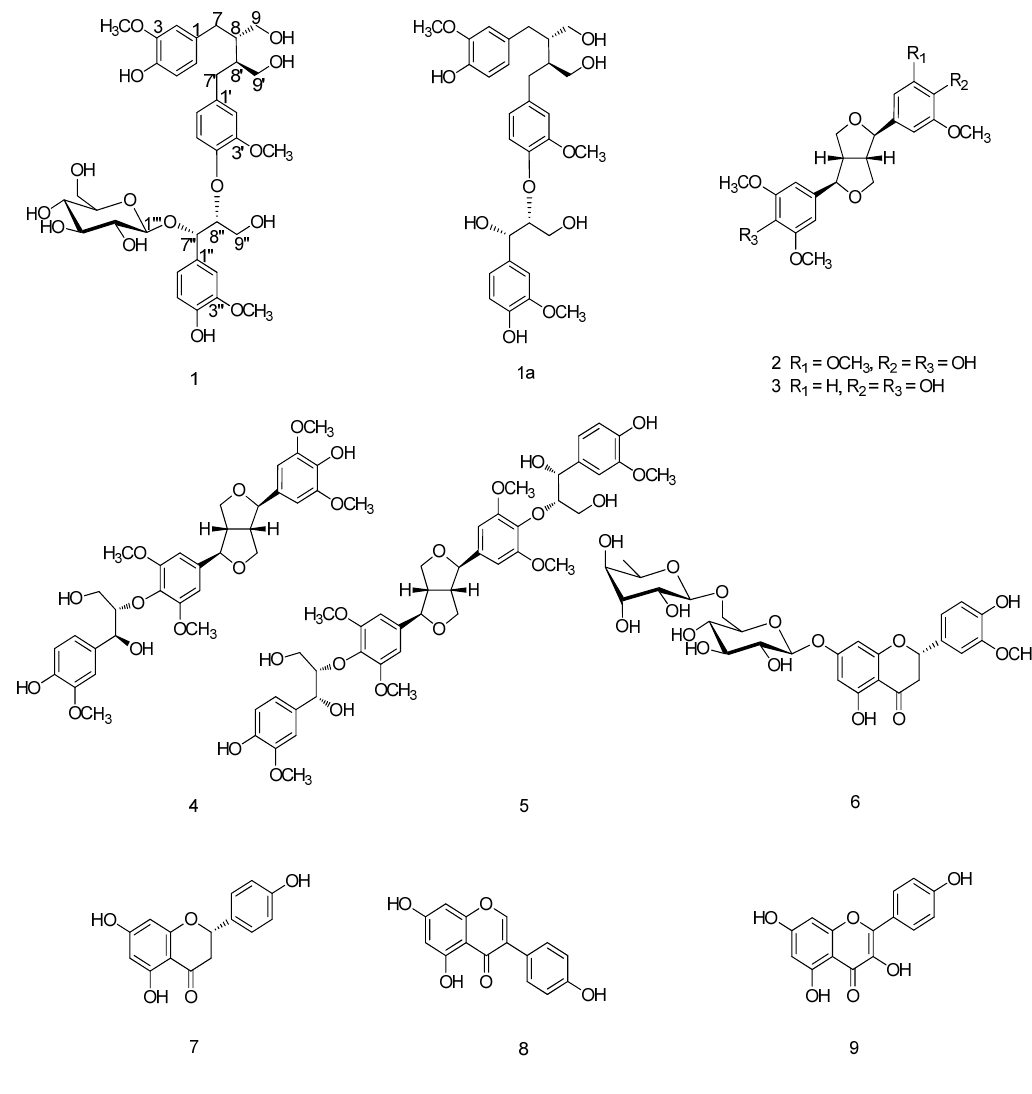
Figure 1. Structures of compounds 1 – 9